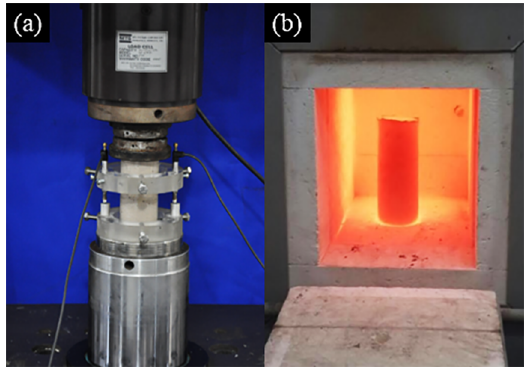
Three cylindrical specimens of each formulation (in room temperature) were initially subjected to compression